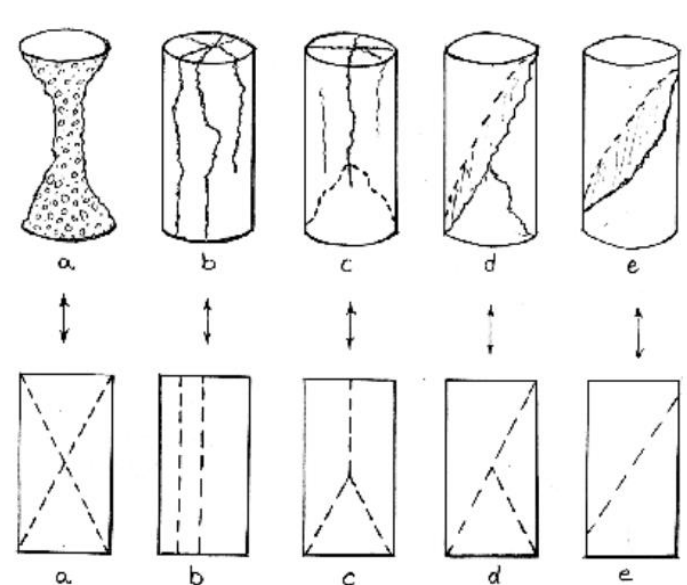
Figure 7 – Types of fractures provided for in NBR 5739/2018 [12]. a) conical fracture b) columnar fracture c) split columnar fracture d) sheared conical fracture e) sheared